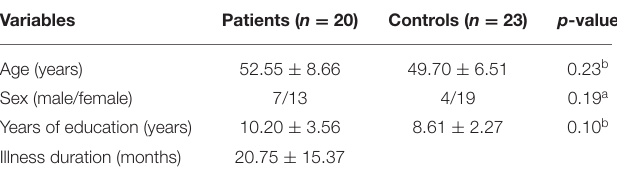
TABLE 1 | Characteristics of